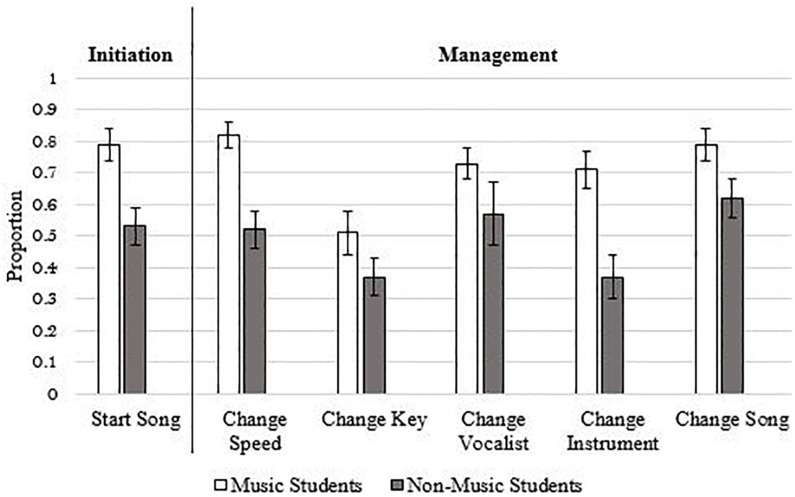
Ability to initiate and manage musical imagery. Errors bars indicate 1 SE. N participants = 58, N episodes = 1,409. Figure is adapted from Cotter and Silvia (2018).